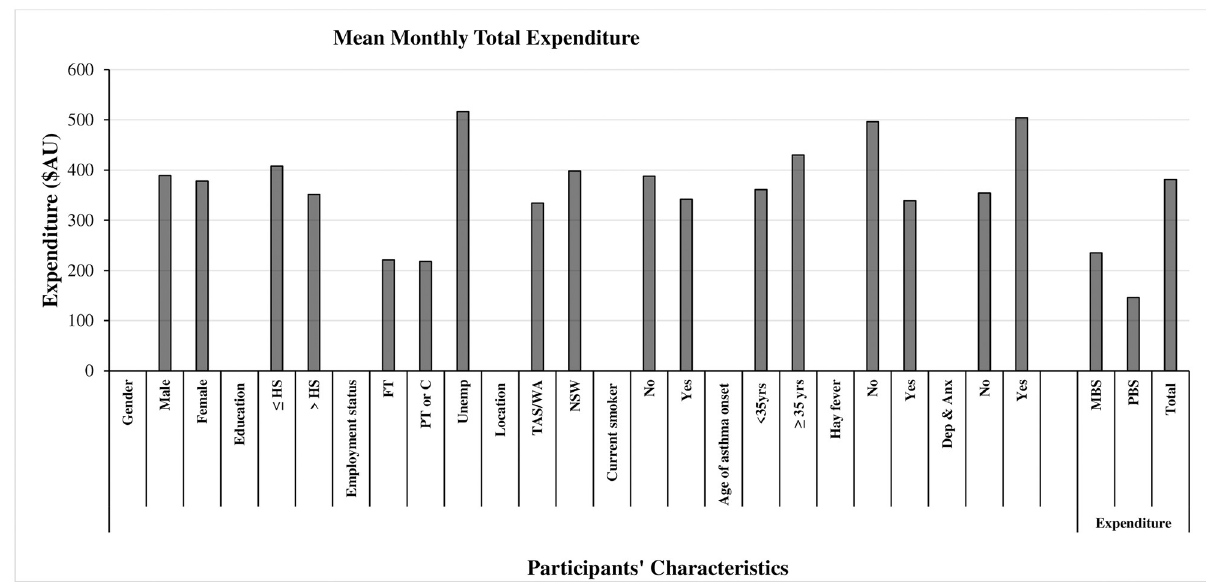
Fig 1. Mean monthly health care expenditure summary by characteristics and by MBS and PBS categories of the study participants ($AU). This presents the unadjusted monthly mean total expenditure of participants by characteristics. HS denotes high school; FT-full time; PT-part time; C- casual; Unemp-unemployed; TAS-Tasmania; WA-Western Australia; yrs-years; Dep & Anx-depression and anxiety; MBS- Medicare Benefits Schedule; PBS-Pharmaceutical Benefits Scheme; and the total is the summation of MBS and PBS